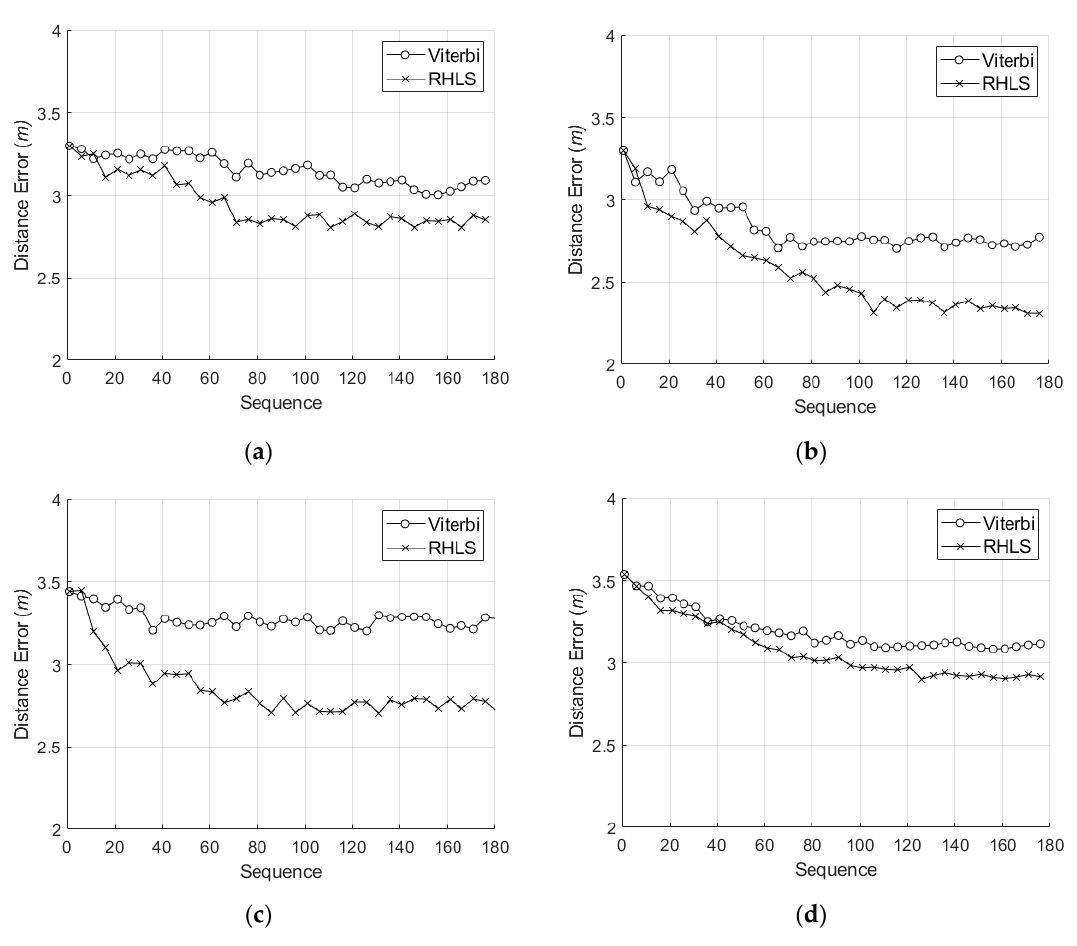
Figure 13. Comparison of tracking accuracy as the sequence progresses: ( a ) main deck; ( b ) A deck; ( c ) first deck; ( d ) second deck.